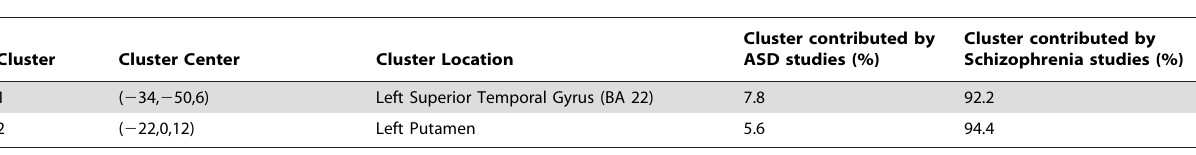
Table 3. ALE clusters formed in more grey matter.